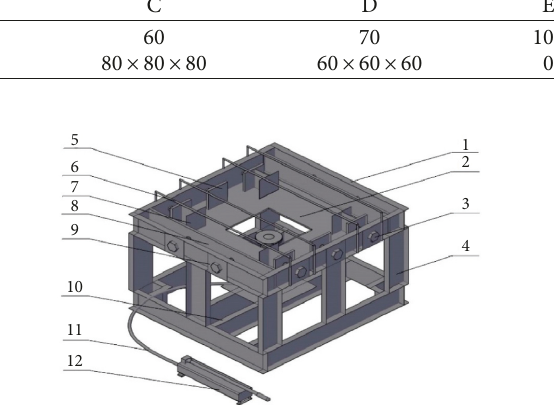
Figure 2: Loading test platform. (1) Platform frame baffle; (2) horizontal fixed platform; (3) limit bolt; (4) support frame; (5) I- shaped limit plate; (6) horizontal support frame; (7) block limit plate; (8) long strip limit plate; (9) rib plate; (10) jack reaction frame; (11) hydraulic pipe; (12) manual hydraulic